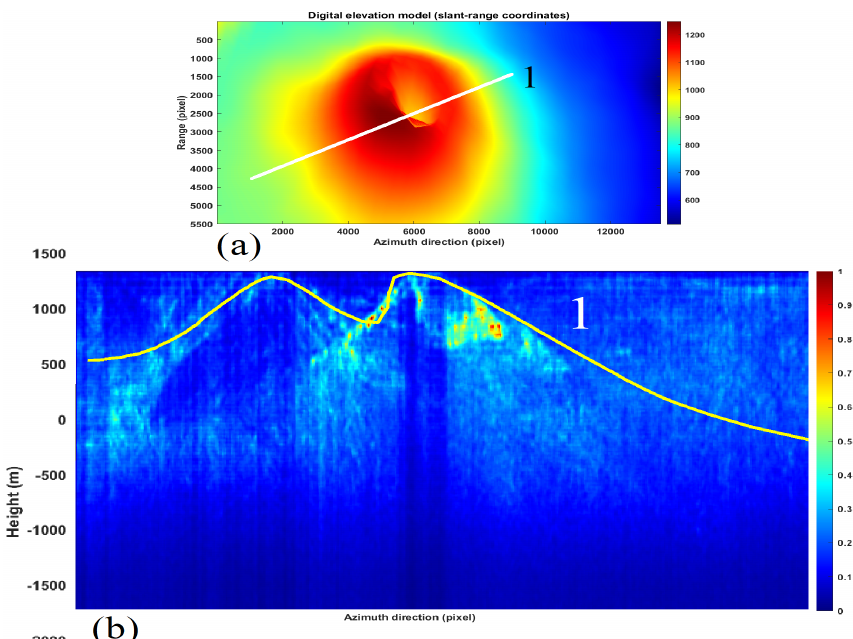
Figure 15. Range-line echographic tomography result (magnitude), and validation through DEM. ( a ) DEM result in the slant-range coordinates. ( b ) Tomographic result (in magnitude), and topographic height (yellow line taken from the white line 1 of Figure ( a )).